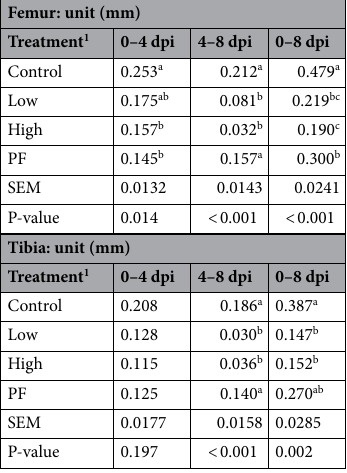
Table 3. Bone growth rate measured by calcein injection method. 1 Control, control group; Low, the lower challenge dose; High, the high challenge dose; PF, pair-feeding group, paired with the High group. 2 Unit: mm. a,ab,b,bc,c Treatments with different letters means a significantly difference between treatments by using Tukey’s HSD test, P < 0.05, N = 10.